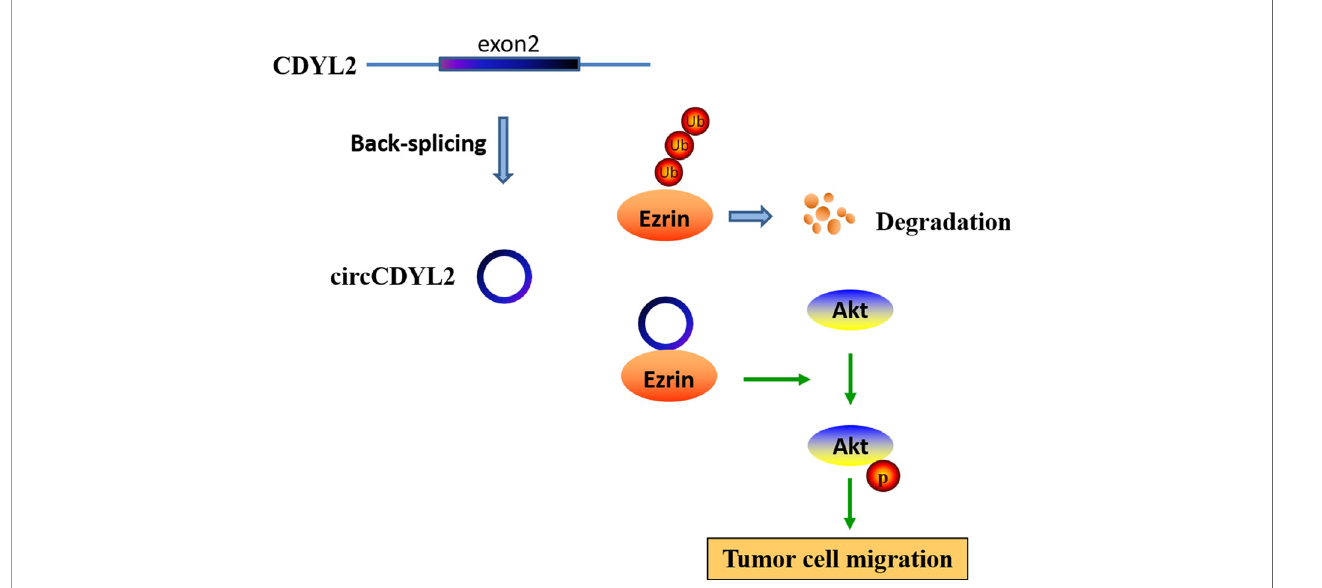
FIGURE 7 | A hypothesis model of circCDYL2 involvement in CRC